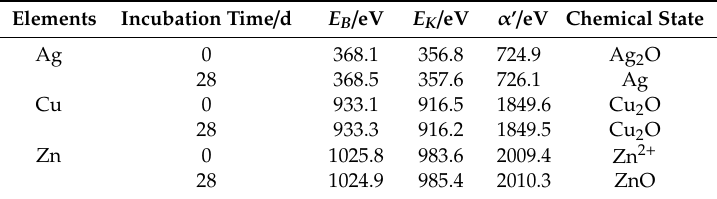
Figure 4. Changes in the concentration of Ag, Cu, and Zn in the oxide layer ( a ) and antibacterial effects ( b ) before and after incubation in saline for 28 days [97,102]. Table 3. Summary of the binding energy ( E B ), kinetic energy ( E K ), and modified Auger parameter ( α ’) values obtained from Ag-, Cu-, and Zn-incorporated oxide layers before and after incubation in saline for 28 days [97,102].